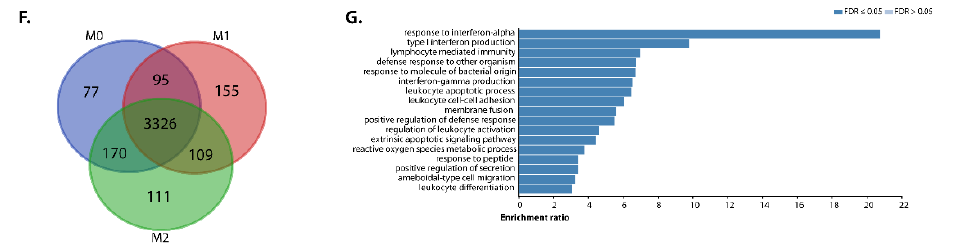
Figure 2. Proteomic analyses of differentially polarised iPSDM. ( A ) Principal component analysis scores plot showing clustering of iPSDM according to their polarisation. ( B ) Histograms displaying the distribution of log2-transformed intensities of samples. ( C ) Scatter plots of protein copy numbers per cell show high correlation of biological replicates (Pearson’s coefficient close to 1). ( D ) Volcano plot showing fold changes in proteins using copy number vs. log p -values from mass spectrometry of M1 and M2 macrophages. ( E ) Volcano plot showing changes in concentrations vs. log p -values. ( F ) Venn diagram showing the number of proteins differentially expressed by polarised iPSDM. ( G ) Gene ontology analysis of the protein hits enriched in M1 iPSDM.